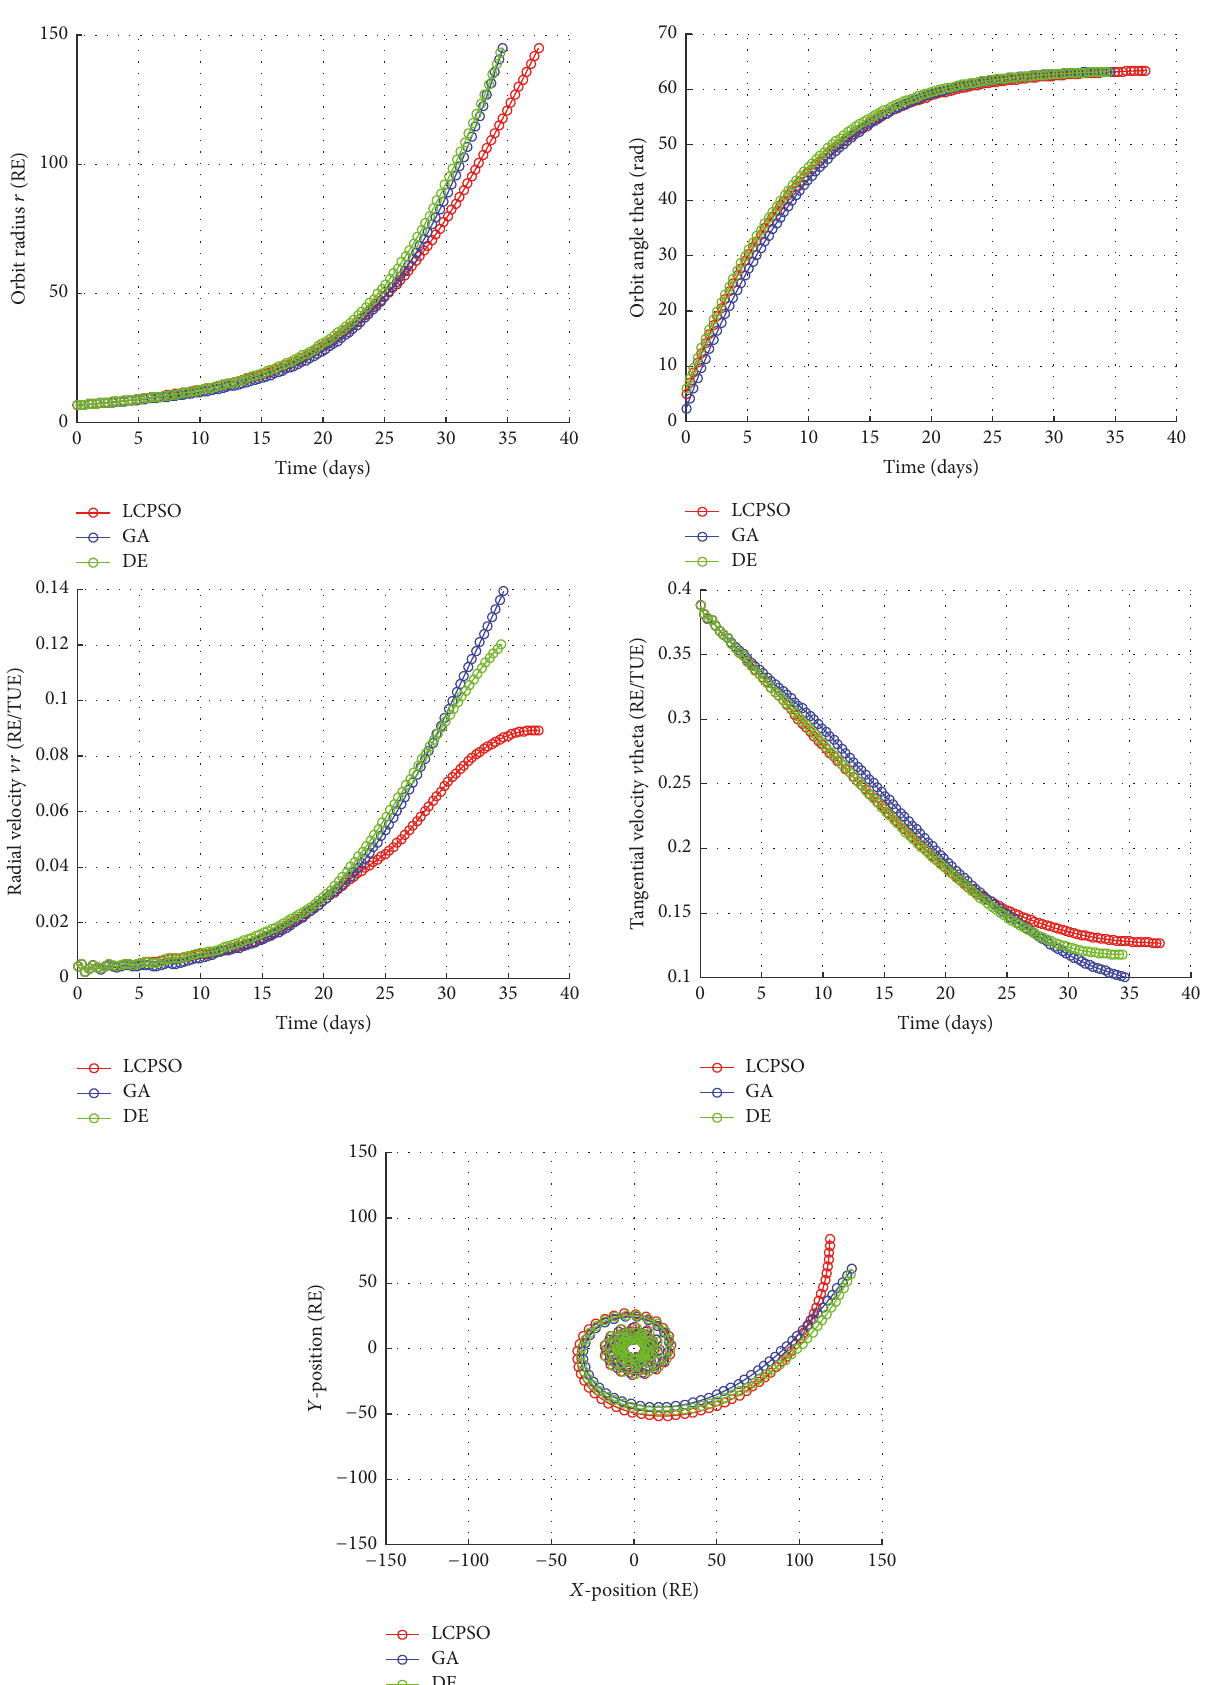
Figure 7: State variables in geocentric